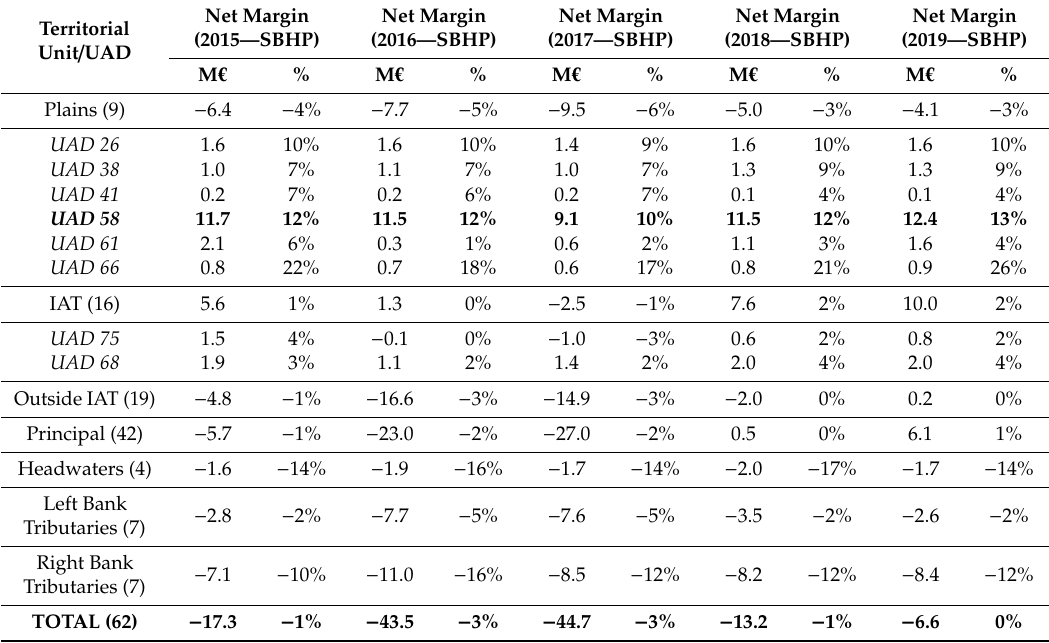
Table 14. Variation in the net margin in the years analysed with respect to the value obtained with the average water applied in the SBHP, examples of some UADs with an increase in the period analysed. Source: SBHP. Own